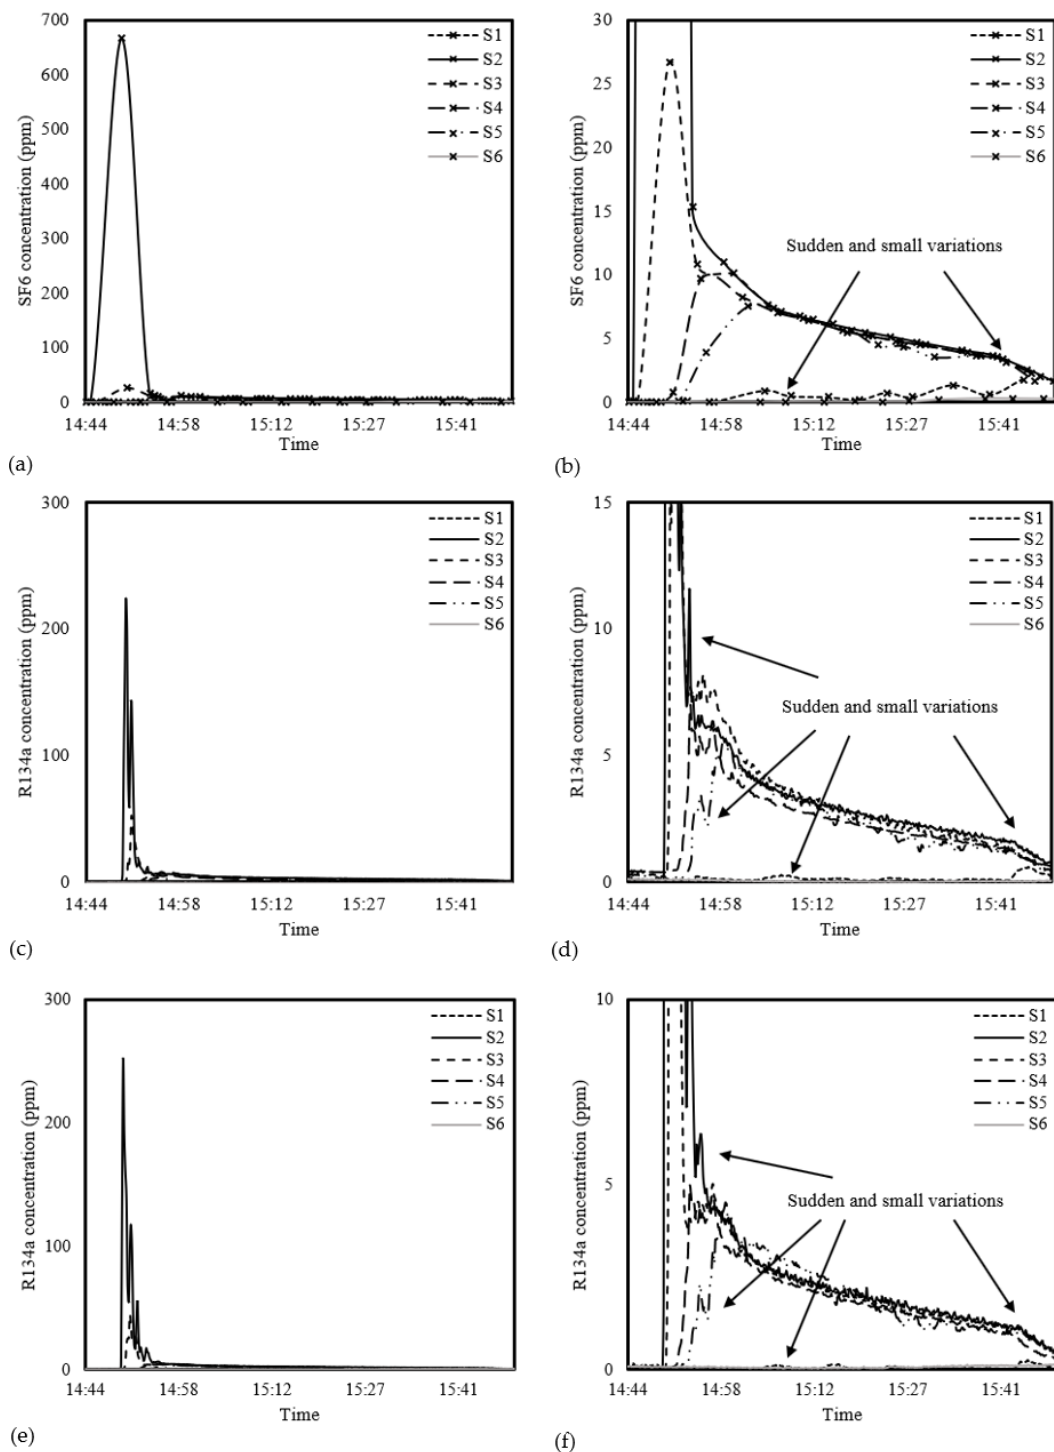
Figure 4. SF 6 and R134a concentrations at six sampling points measured by the ( a,b ) reference sys- tem and ( c–f ) two novel system receivers at ( a,c,e ) a complete tracer gas concentration range and ( b,d,f ) a smaller range for detailed